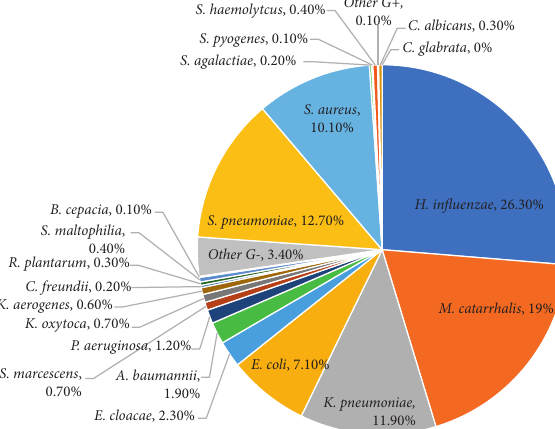
Figure 2: Composition ratio of pathogens isolated from lower respiratory tract from 2011 to 2020.